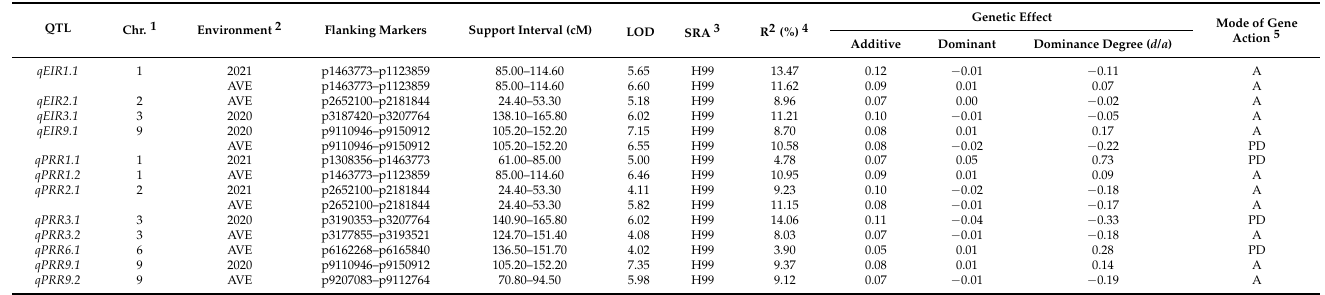
Table 3. Information on the quantitative trait loci (QTLs) identified for the EIR and PRR.